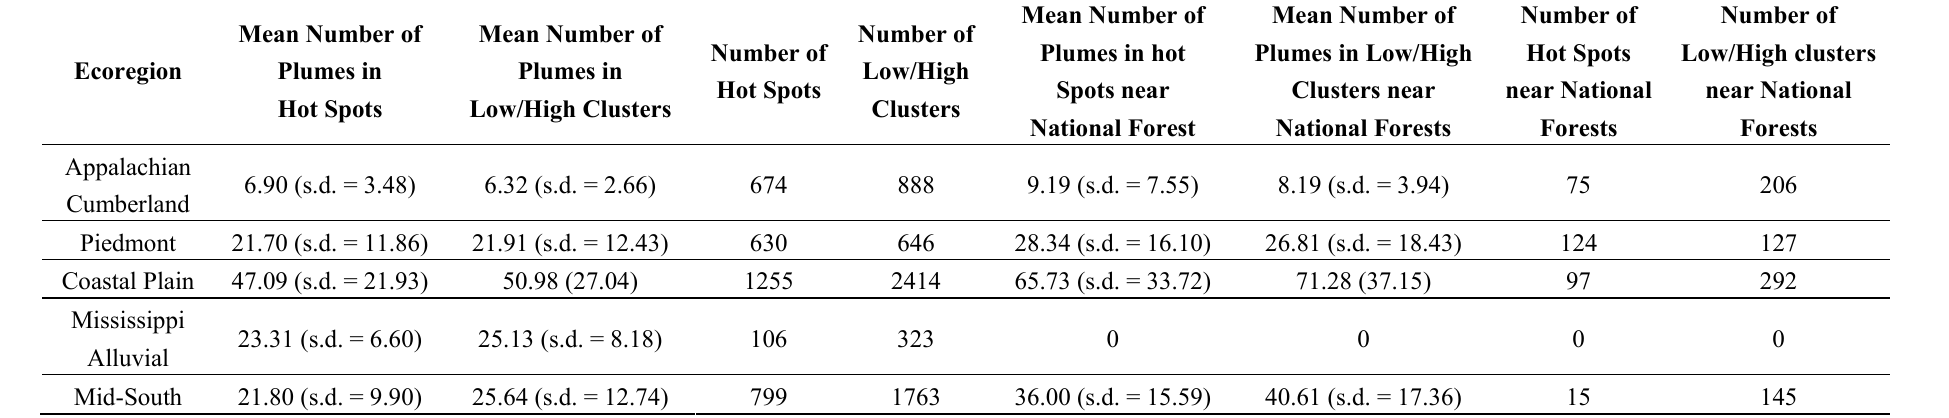
Table 6. Mean plume count in hot spot and low/high clusters generally and within 1 mile of a National Forest. Number of hot spots and low/high clusters generally and within 1 mile of a National Forest—winter.